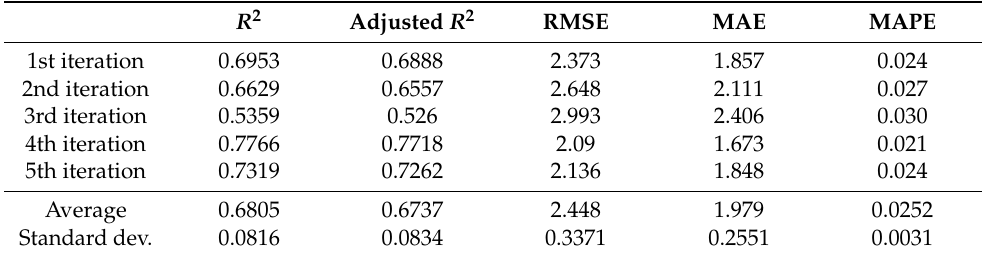
Table 7. The evaluations on GRU model, Architecture 2, on testing